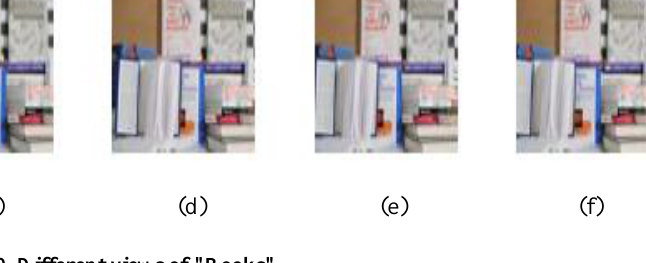
Figure 9. Different views of